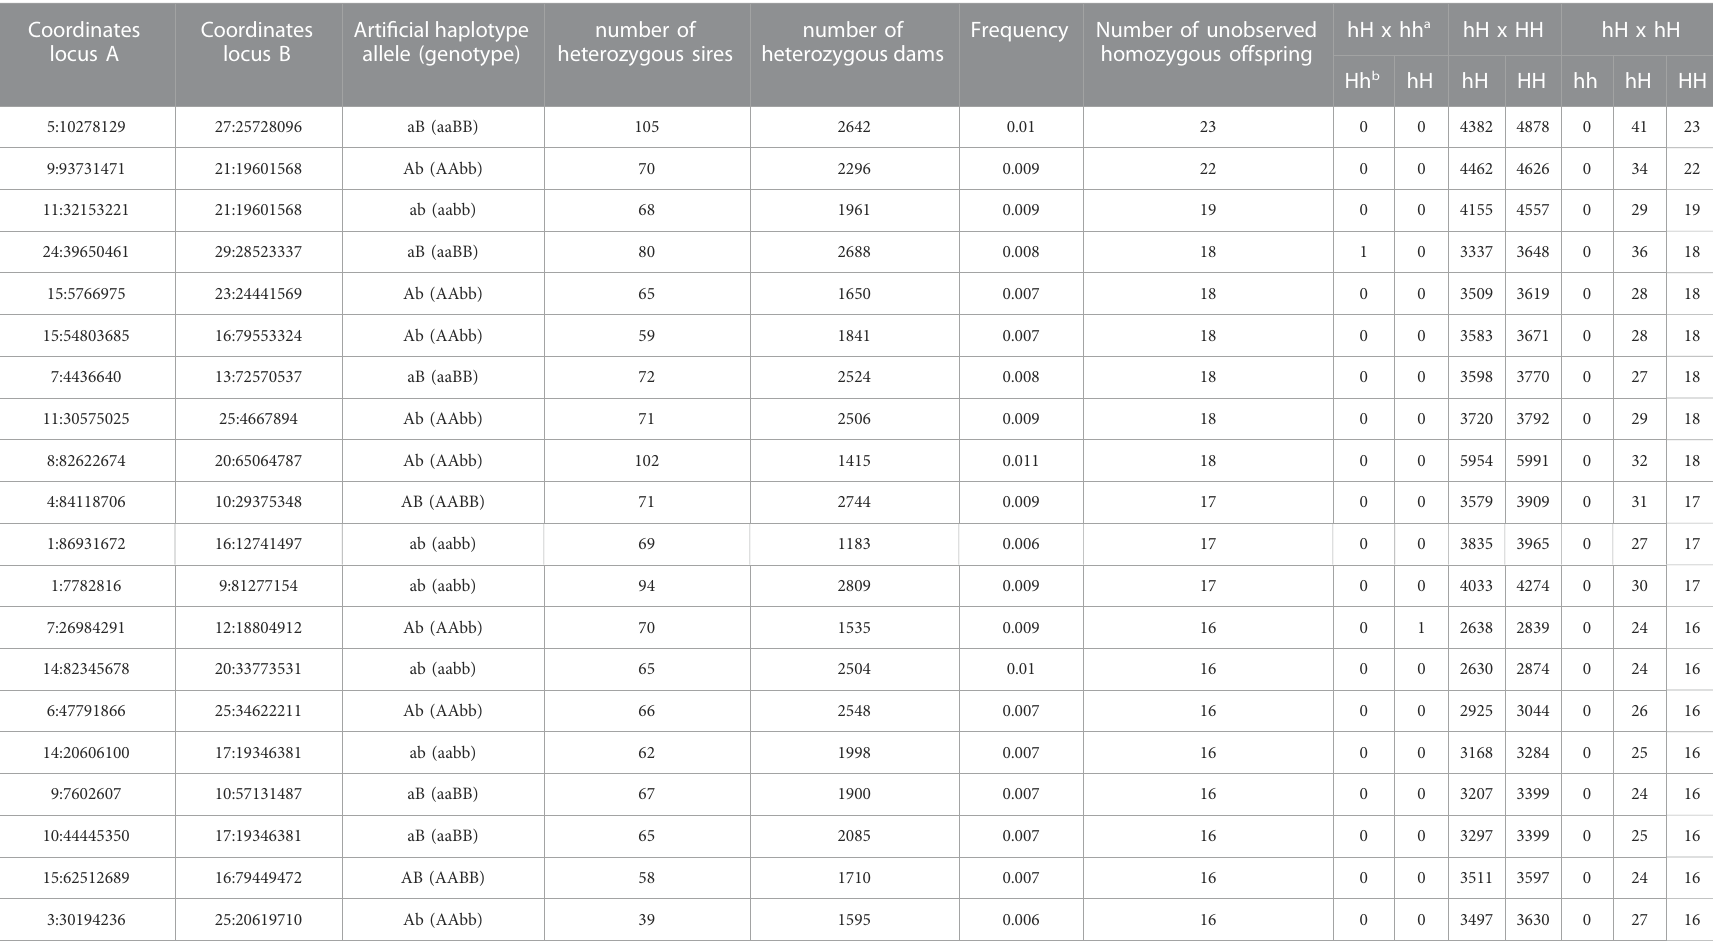
TABLE 4 Pairs of genomic regions identi fi ed with epistatic transmission ratio distortion (TRD) in Holstein cattle with recessive patterns. Coordinates locus